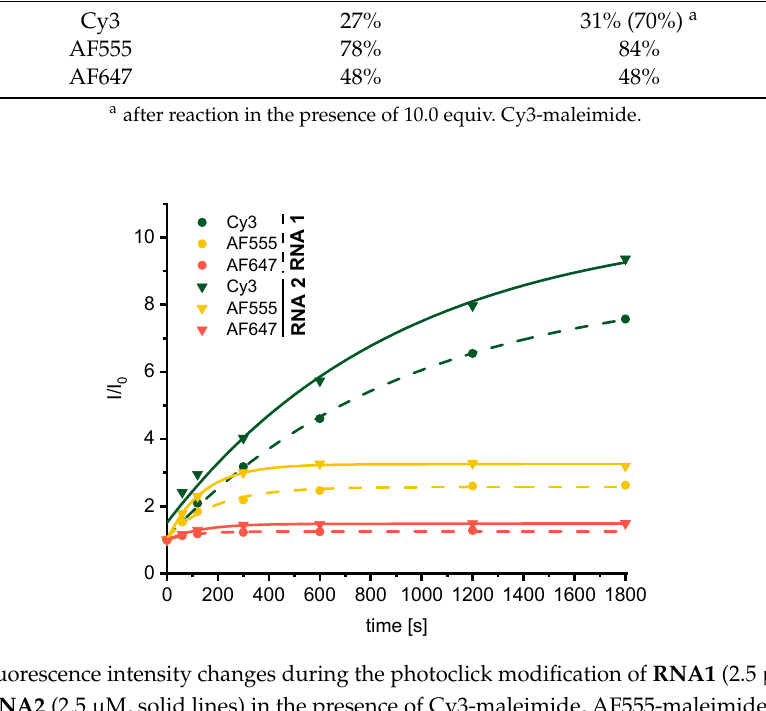
Dye Adduct of RNA1 RNA2